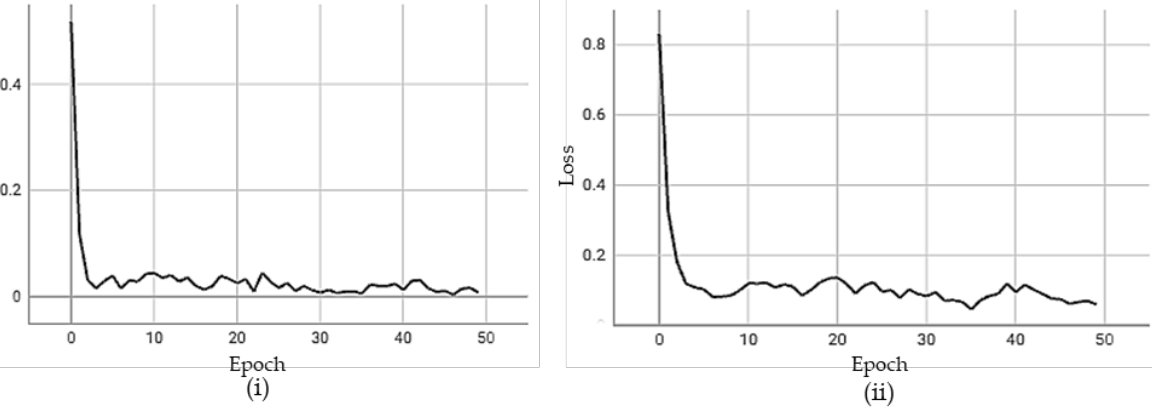
Note: mAP denotes mean average precision, F1 denotes harmonic mean of precision and recall, FP denotes false positive, IoU denotes intersection over union and BFLOP denotes billion floating point operations.